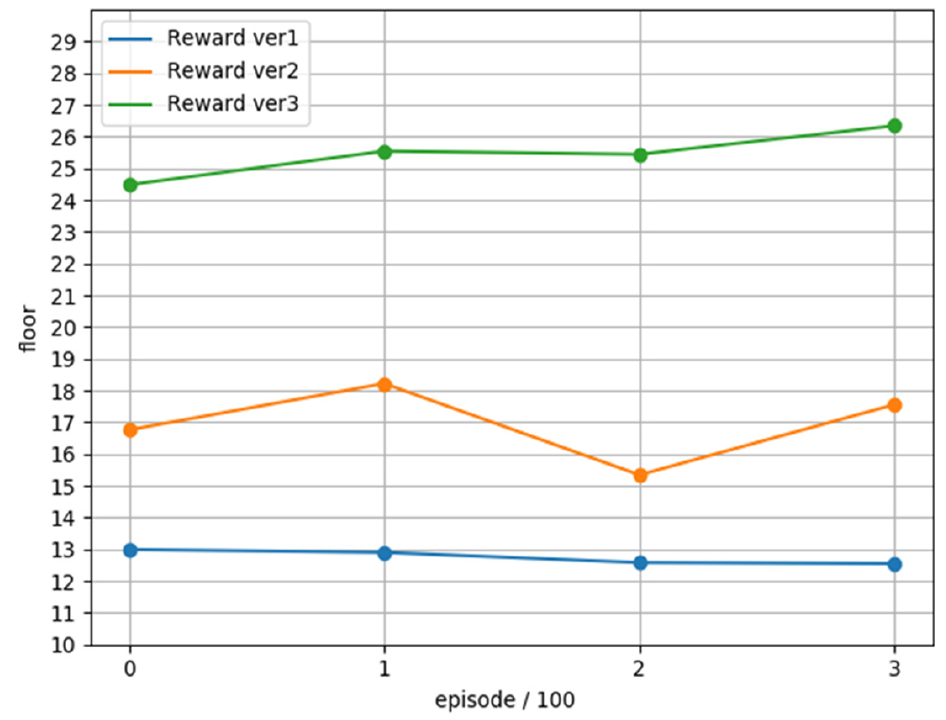
Figure 18. Verify the results of 400 rounds separately.